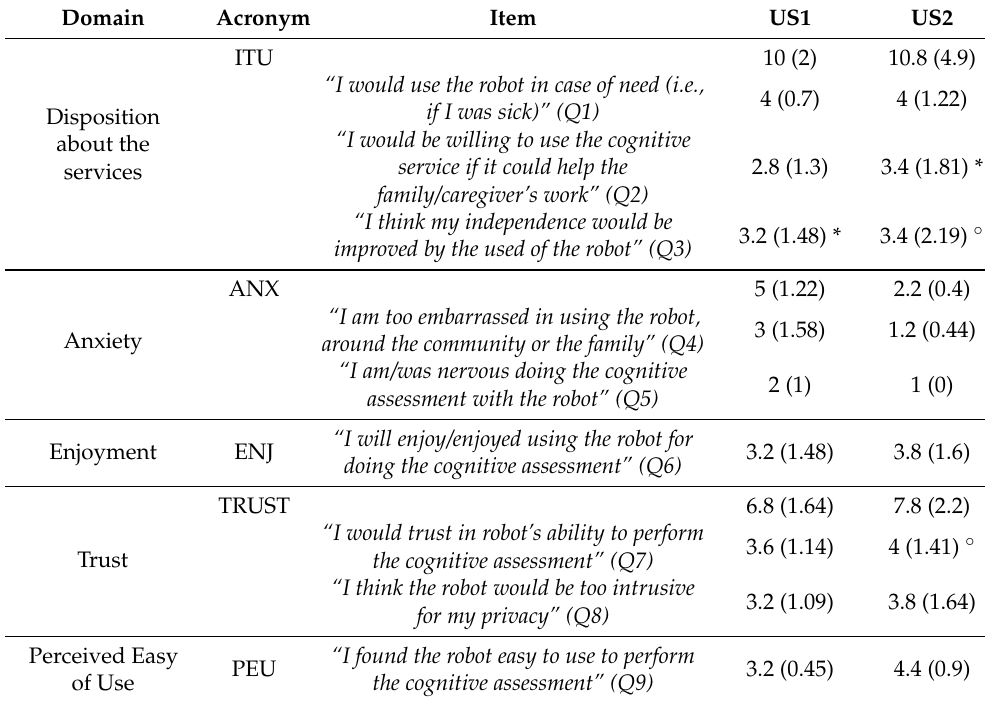
Table 5. The average and standard deviation of each domain and item of the ad-hoc Usability questionnaires administrated before (US1) and after (US2) the cognitive